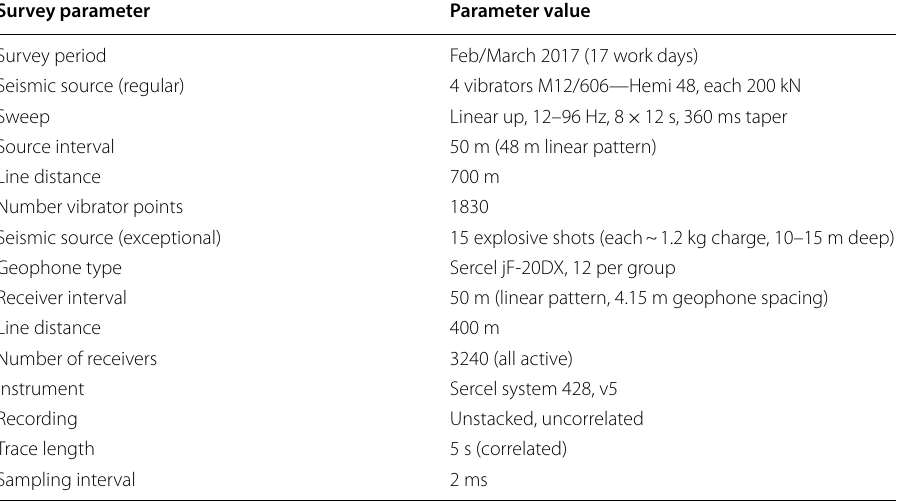
Table 1 Acquisition parameters of the 3‑D seismic survey in Groß Schönebeck Survey